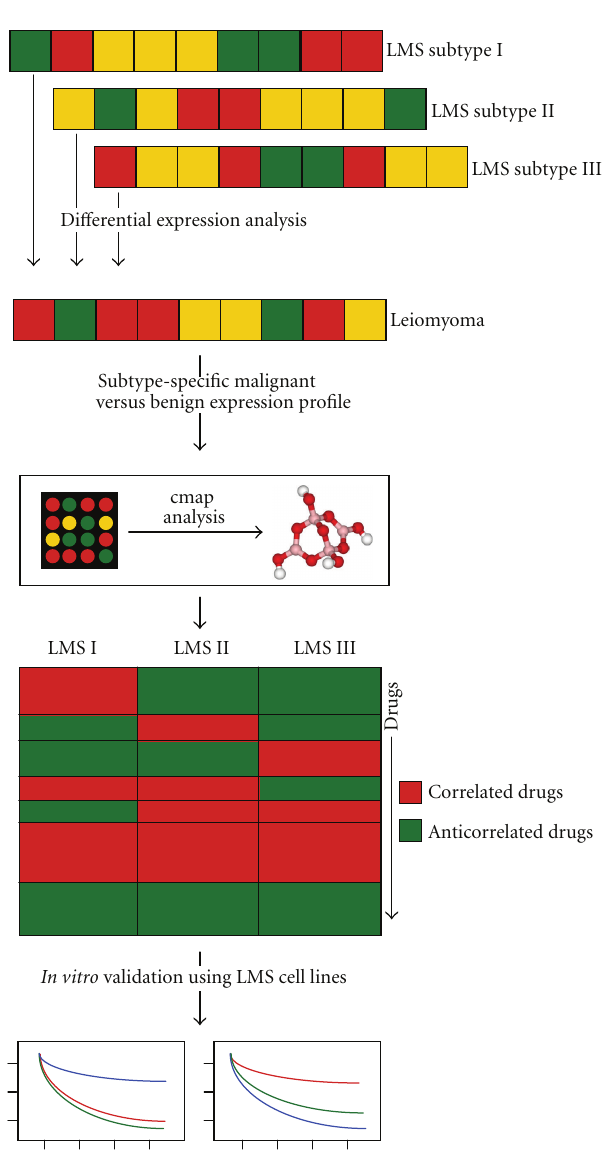
Figure 1: Overview of analytical and experimental workflow. Gene expression profiles from each of the three LMS subtypes were compared to gene expression profiles from LM to identify the top 100 “up” and top 100 “down” di ff erentially expressed genes for each subtype compared with LM. These three pairs of gene lists were then uploaded to cmap to estimate cmap enrichment scores linking drugs with LMS subtype expression signatures. 11 drugs, with a range of cmap enrichment scores, were then tested against three LMS cell lines using in vitro drug response